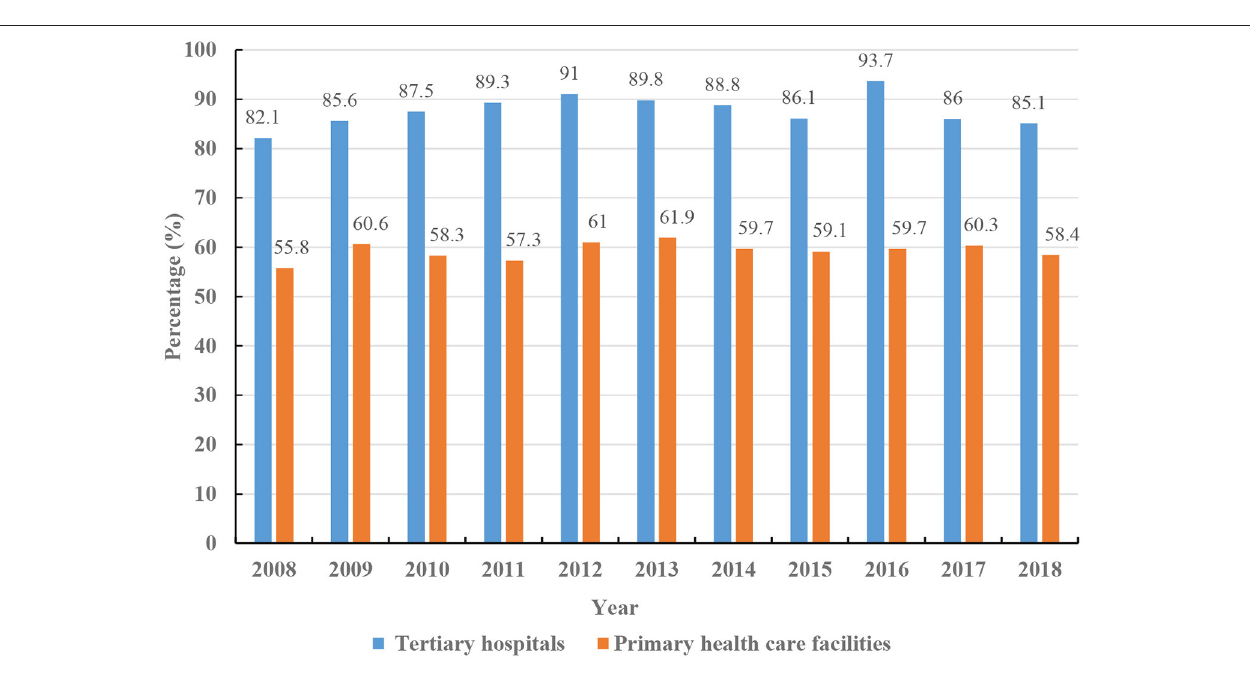
FIGURE 3 | The bed use rate in urban tertiary hospitals and local primary healthcare